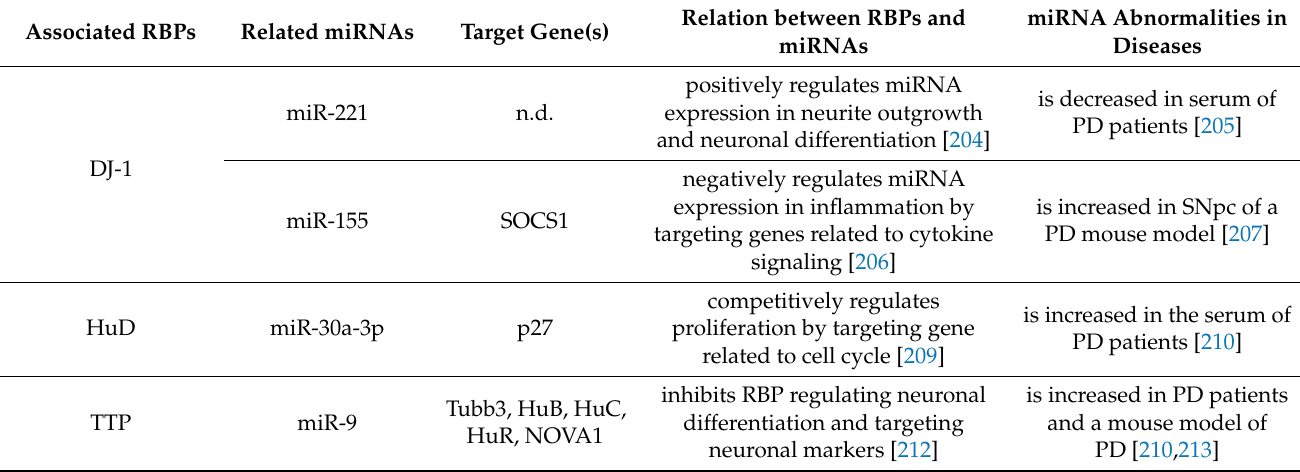
Table 4. List of interactions between the RBPs and miRNAs in